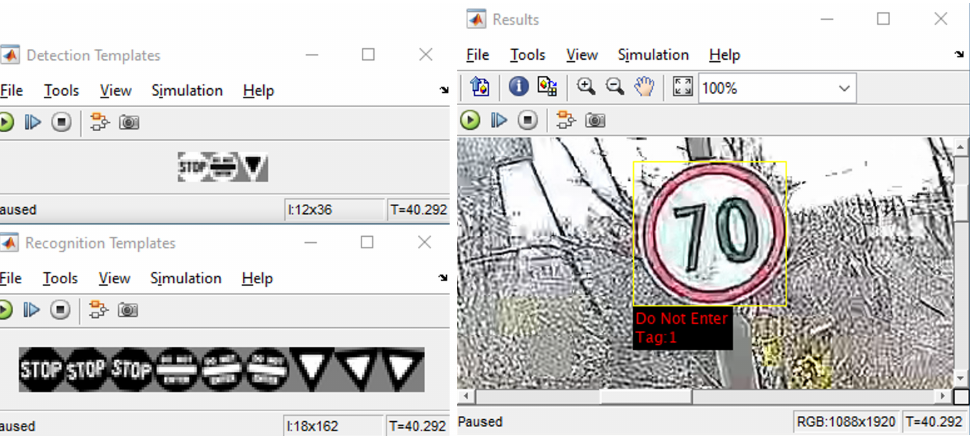
Figure 20. Example of traffic sign detection and